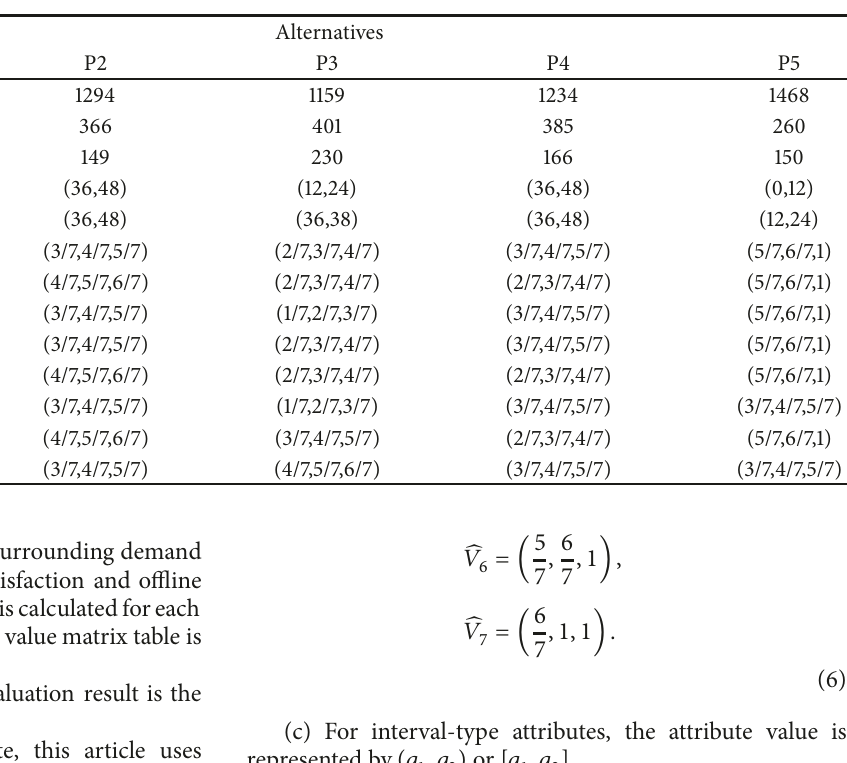
Table 1: Offline channel, attribute evaluation